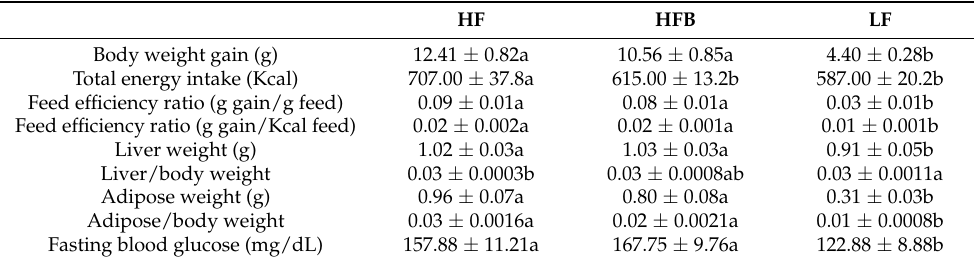
Table 2. Anthropometrics in mice fed different diets for 6